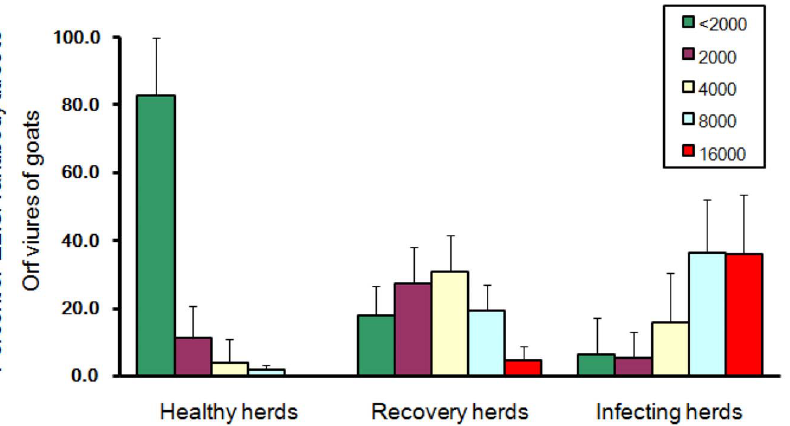
Figure 3. ELISA antibody titers to orf virus of goats from farms with different infection statuses in Fujian Province.